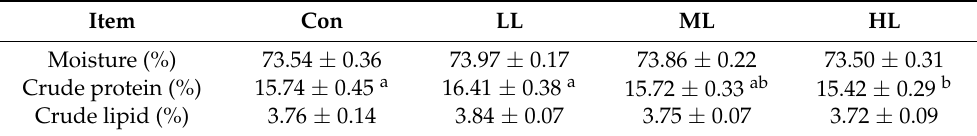
Table 4. Effects of dietary laminarin inclusion on flesh composition of juvenile largemouth bass fed the experimental diets for 28 days